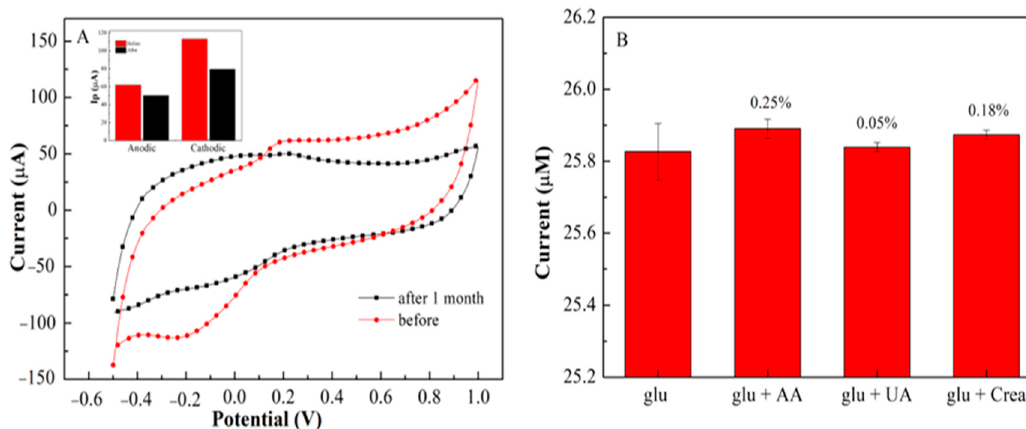
Figure 8. ( A ) CV stability of 1 − month storage on PEDOT:PSS/Ti 3 C 2 /GQD/GOx in the prsense 500 µM glucose; ( B ) Interference study of glucose on the PEDOT:PSS/Ti 3 C 2 /GQD − GOx SPCE.